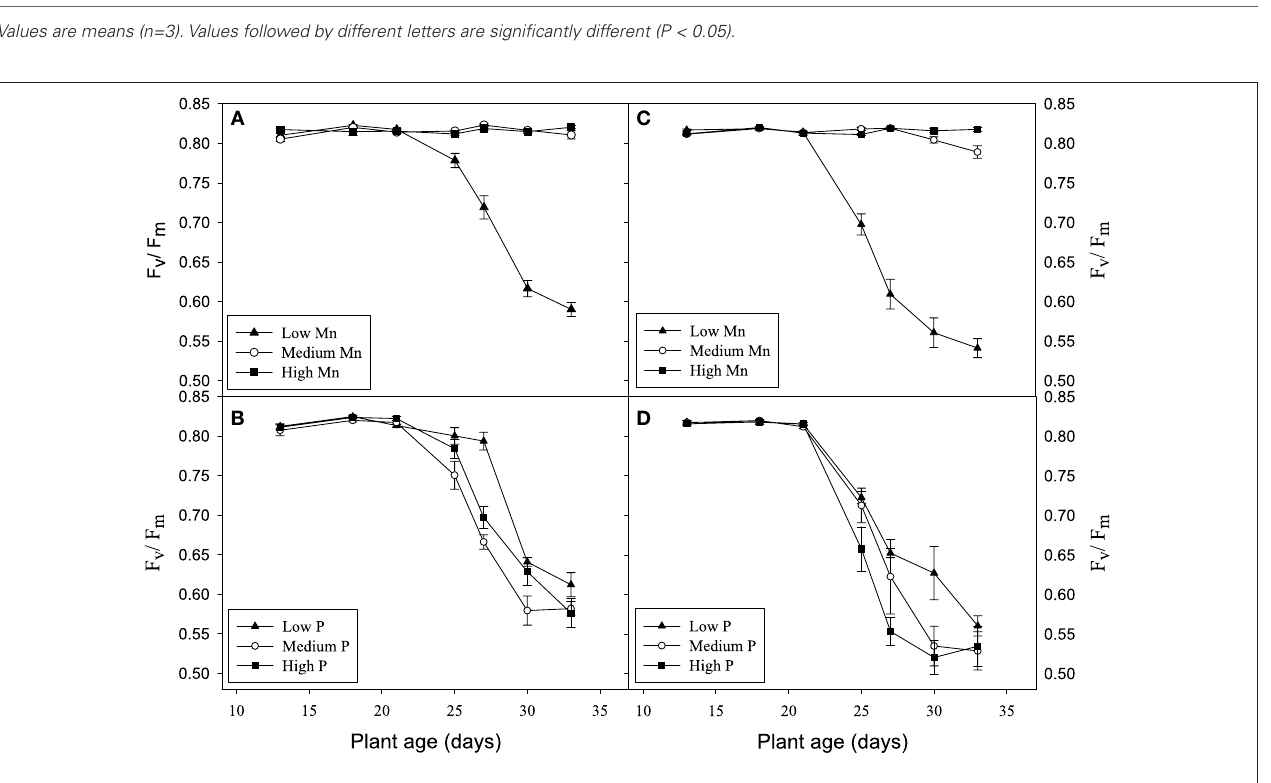
/F values depending on the Mn level summarized across Inserts (A) and (C) show F v m the P levels. Inserts (B) and (D) show F /F values for plants grown at low Mn supply v m and increasing P additions. Each data point represents the mean ± SE ( n = 6–18).